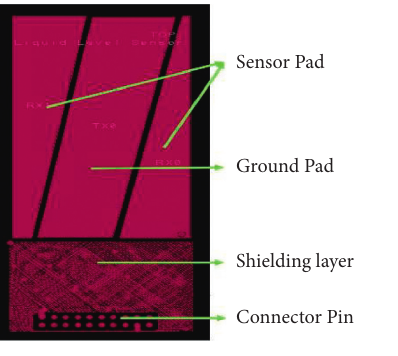
Figure 10: Sensor pattern. Table 2: Dielectric constants of insulation materials.